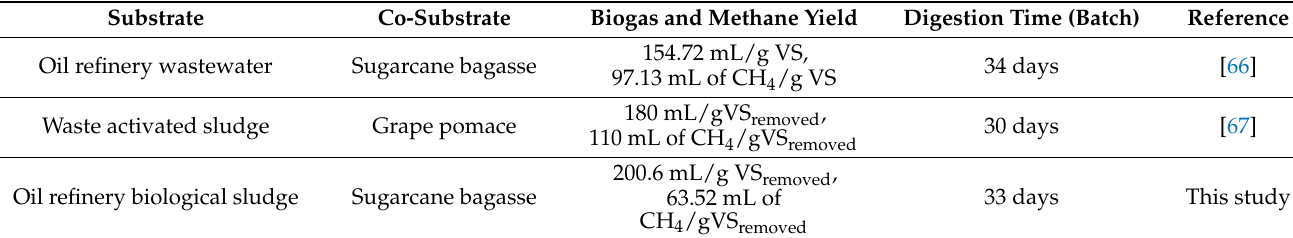
Table 7. Various substrates to enhance biogas yields during the anaerobic co-digestion process. Substrate Co-Substrate Oil refinery